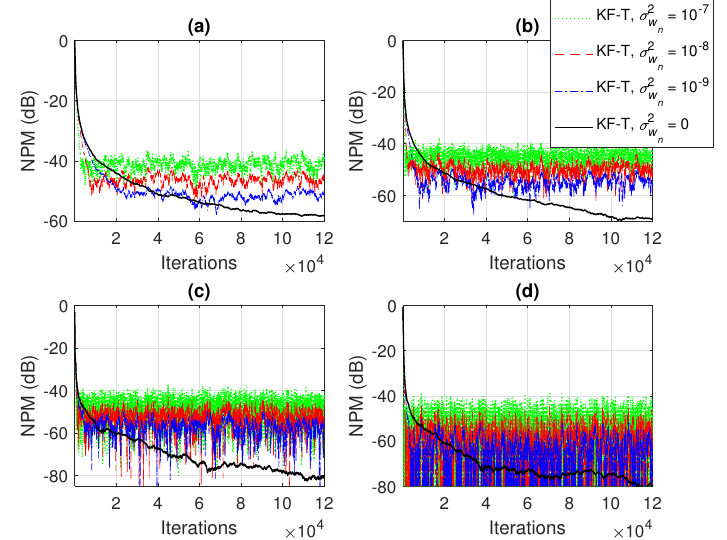
Figure 2. Normalized projection misalignment (NPM) of the KF-T using different values of σ 2 w , n = 1,2, . . . , N , for the identification of the individual impulse responses, h n ( t ) , n = 1,2, . . . , N . n